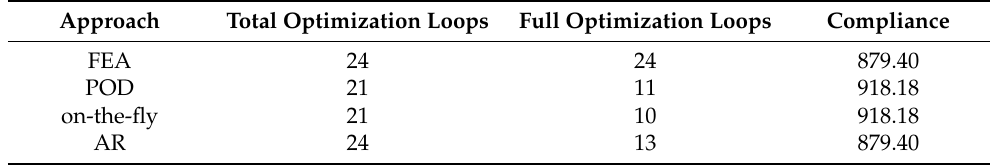
Table 1. Bridge test example: Results of each MOR approach as well as the classic implementation